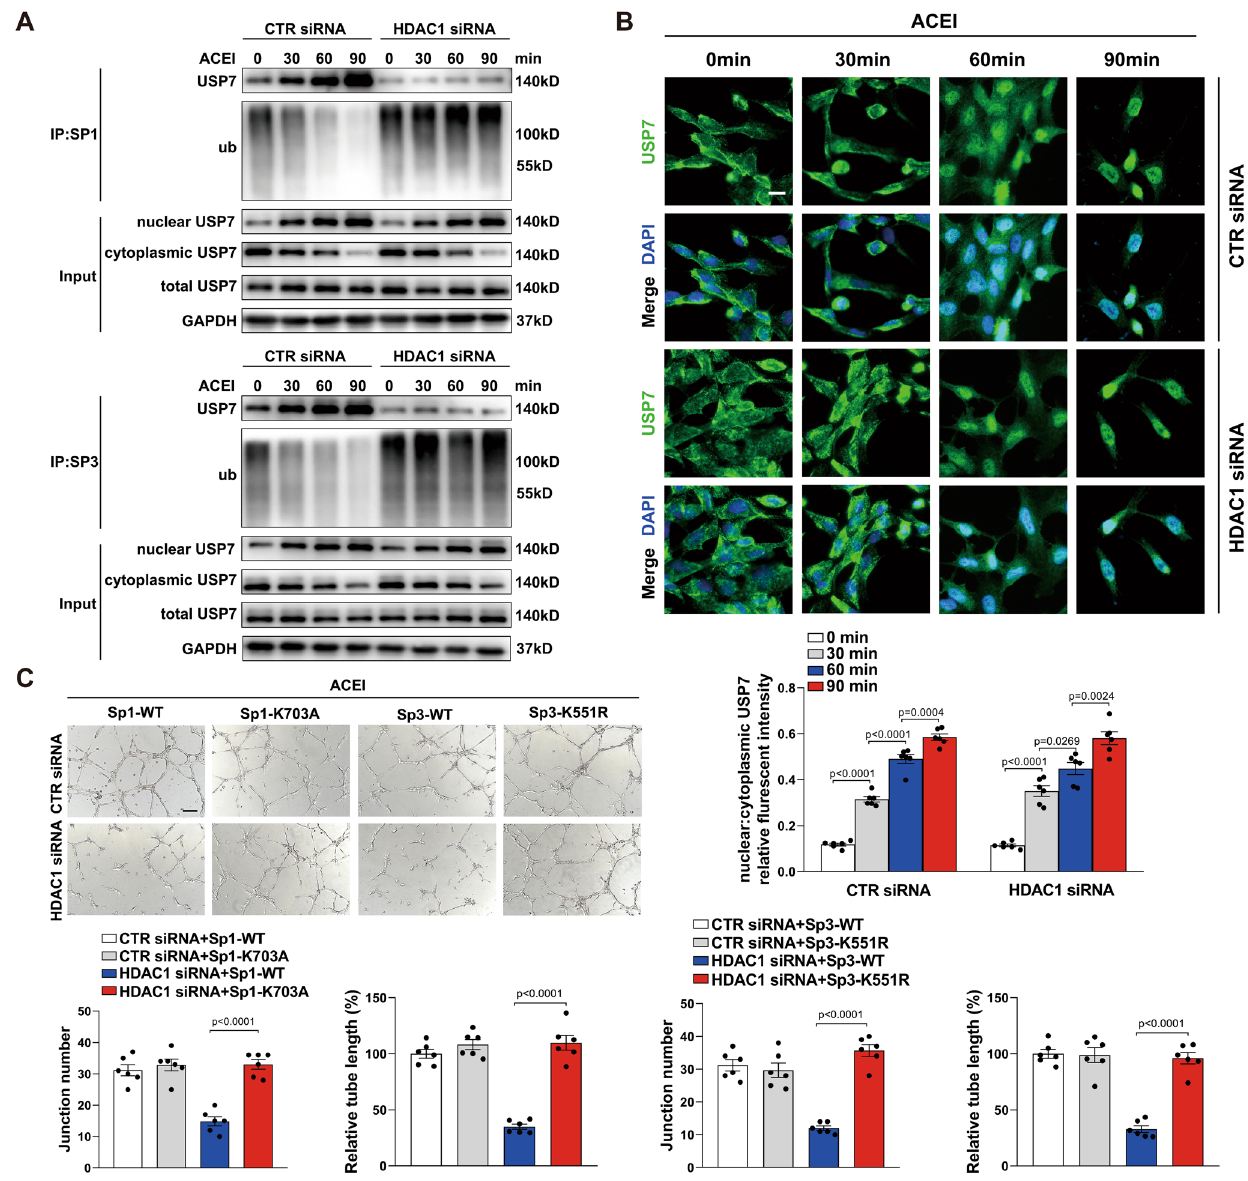
Fig. 6 | ACEI increases nuclear localization of USP7. A Representative western blot analysis of USP7 and ubiquitin after anti-Sp1 (top) or anti-Sp3 (bottom) immunoprecipitation of HUVECs treated with ACEI for different time, as indicated in combination with CTR siRNA or histone deacetylase 1 (HDAC1) siRNA. The pro- teinlevelsofUSP7weremeasuredbywesternblotanalysisinnuclear,cytoplasmic, and whole-cell lysates. B Representative confocal microscopy images of immuno- fl uorescencestaining for USP7 and DAPIinHUVECs treatedwith ACEI for 0,30,60 and90min,incombinationwithCTRsiRNAorHDAC1siRNAasindicated.Scalebar: